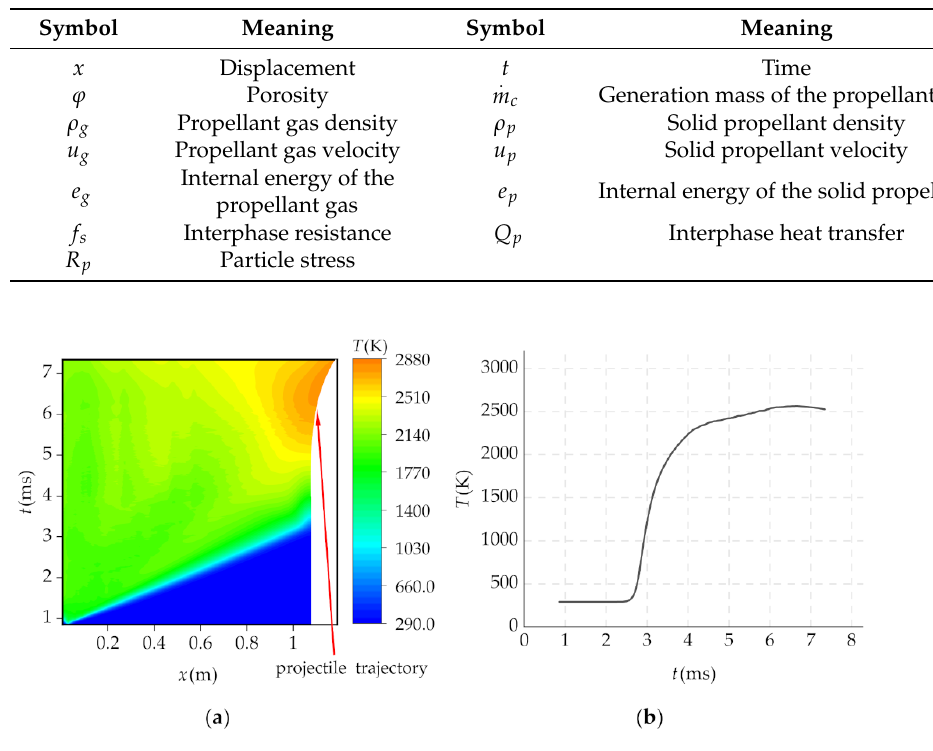
Figure 7. ( a ) Displacement–time–temperature data of the propellant gas; ( b ) time–temperature data of the propellant gas at 0.9 m.